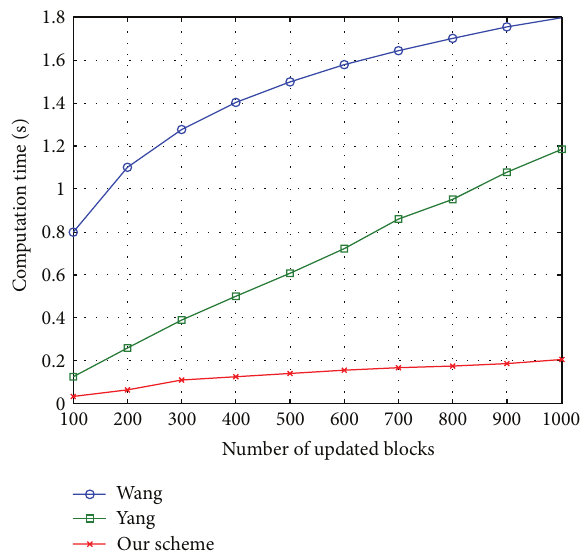
Figure 8: Comparison of computation cost under different number of update requests.